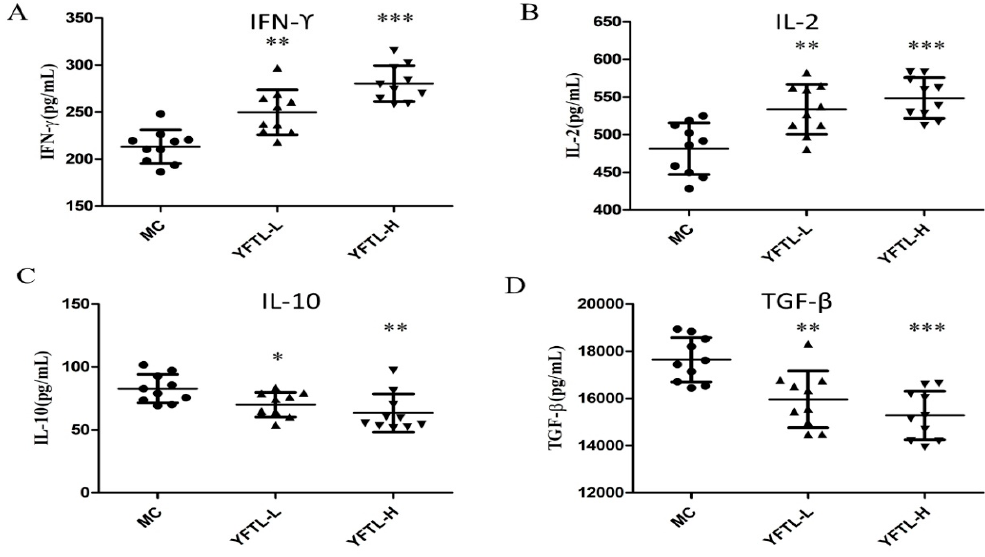
Figure 6. Effect of YFTL on cytokines production in the serum of LLC tumor-bearing mice. ( A ) IFN- γ ; ( B ) IL-2; ( C ) IL-10; ( D ) TGF- β 1. Data are expressed as mean ± SD. * p < 0.05, ** p < 0.01, and *** p < 0.001 vs. the MC group.